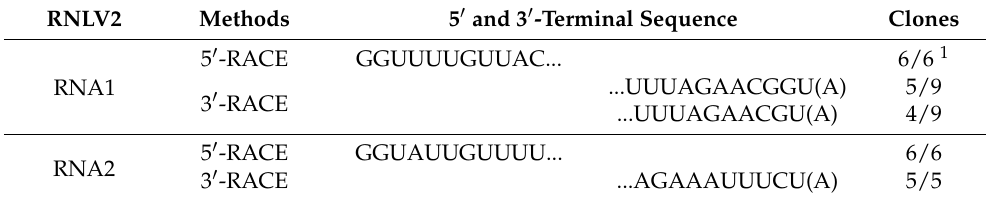
Table 2. Terminal sequences of RNLV2 RNA1 and